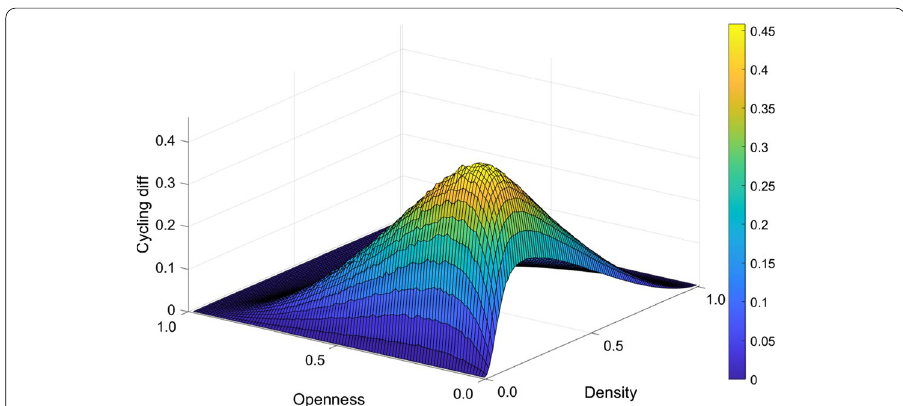
Fig. 3 Cycling in symmetric and asymmetric (scale-free) random networks. The vertical axis shows the average difference between the Finn cycling index measured in Barabási-Albert type scalefree networks and the Erdő-Rényi type random networks for a given density and